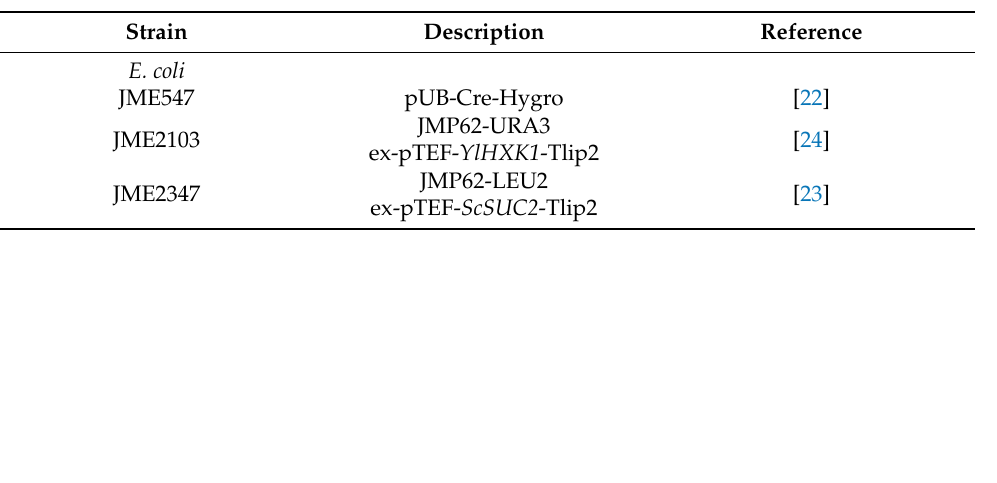
Table 1. Plasmids and strains used in this